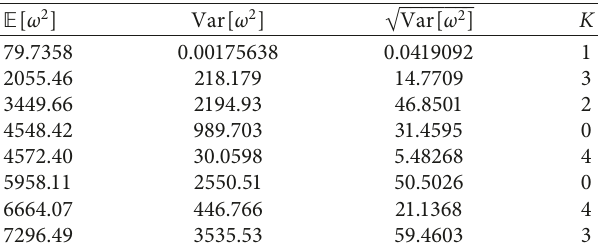
Figure 3: Variances of the tower configuration near the manufacturing defect: components of the first (left) and third (right) eigenmodes for K � 1. Solution computed with p � 4 and L � 3 (165 collocation points). (a) Component μ of the first eigenmode. (b) Component μ of the third eigenmode. (c) Component v of the first eigenmode. (d) Component v of the third eigenmode. (e) Component w of the first ei- genmode. (f) Component w of the third eigenmode. Table 1: Statistics and wavenumbers of the eight smallest (in expected value) eigenvalues of the tower configuration as defined by the wavenumber K .